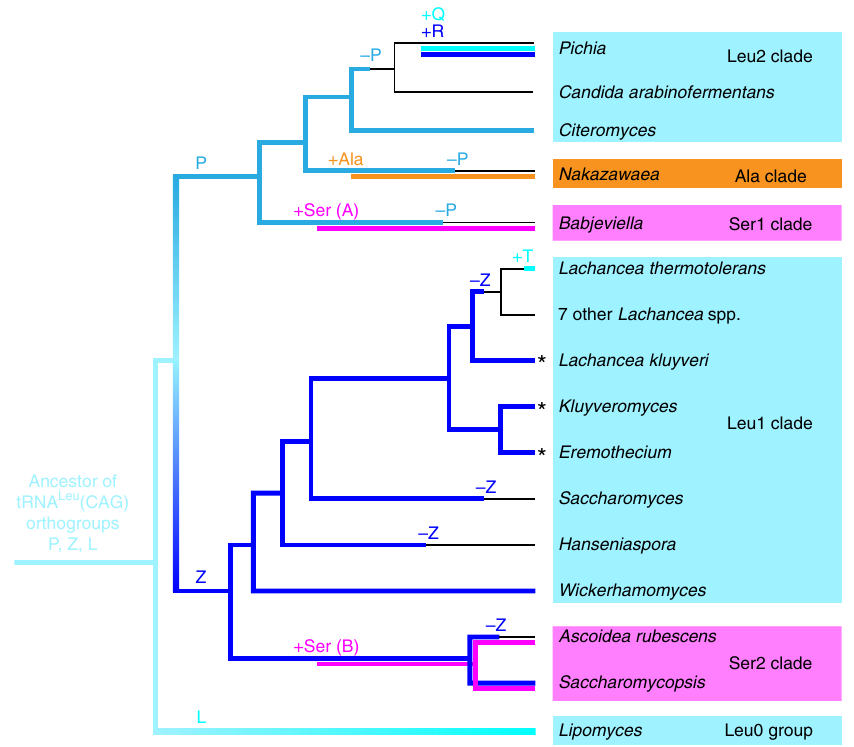
Fig. 4 Summary of evolutionary losses and gains of tRNAs with CAG anticodons. Colored branches on the tree indicate presence of tRNA Leu (blue), tRNA Ala (orange), and tRNA Ser (pink) molecules, with shades of blue indicating different tRNA Leu orthogroups (designated P , Z , L , Q , R , and T ; Supplementary Fig. 9; Supplementary Note 3). Plus and minus symbols indicate inferred gains and losses of tRNA types. For each branch, only some representative genera or species are named. Asterisks indicate taxa with large introns in tL CAG -Z . Species with no tRNA CAG gene (thin lines) translate CUG as Leu by wobble using tRNA Leu